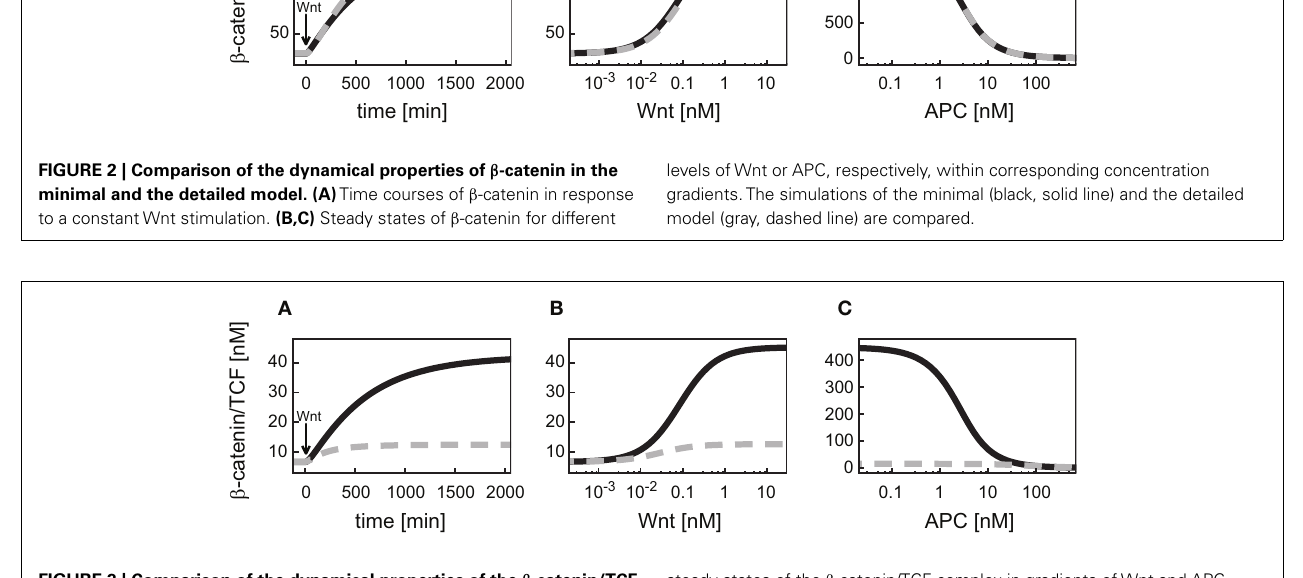
FIGURE 3 | Comparison of the dynamical properties of the β -catenin/TCF complex in the minimal and the detailed model. (A) Time courses of the β -catenin/TCF complex in response to constantWnt stimulation, and (B,C)